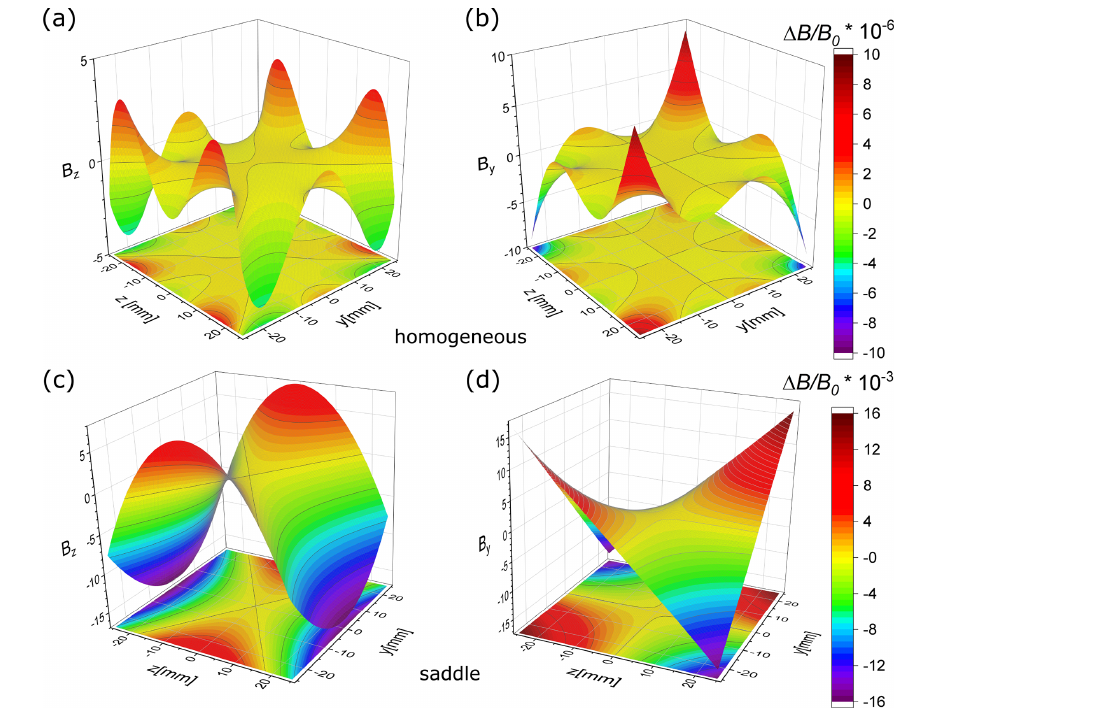
in the zy plane for optimized coil parameters are shown for B z in (a) and B y in (b) , Figure 2. Calculated relative flux densities (cid:49)B B respectively. Relative values for B z and B y when currents are reversed for saddle field configuration are displayed in (c) and (d)